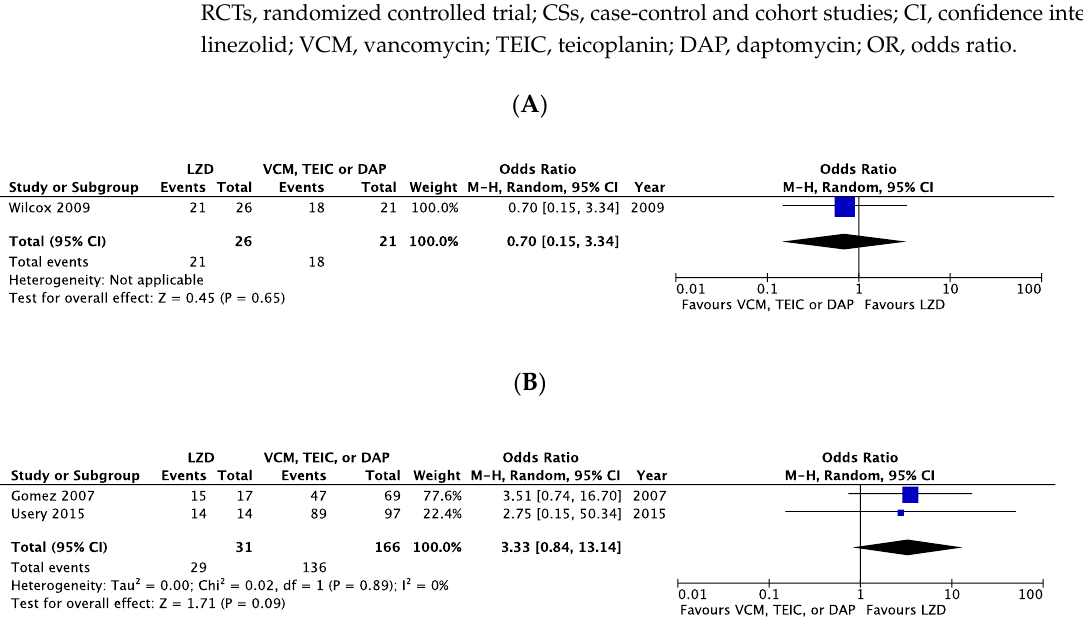
Figure 4. Forest plots of microbiological cure rates in patients with MRSA bacteremia treated with LZD versus VCM, TEIC, or DAP. ( A ) RCTs; ( B ) CSs. The vertical line indicates no significant difference between compared groups. Mantel–Haenszel ORs are represented by diamond shapes, and 95% CIs are represented by horizontal lines. Squares indicate point estimates, and the square size indicates the weight of each study included in the meta-analysis. MRSA, methicillin-resistant Staphylococcus aureus ; RCTs, randomized controlled trial; CSs, case-control and cohort studies; CI, confidence interval; LZD, linezolid; VCM, vancomycin; TEIC, teicoplanin; DAP, daptomycin; OR, odds ratio.